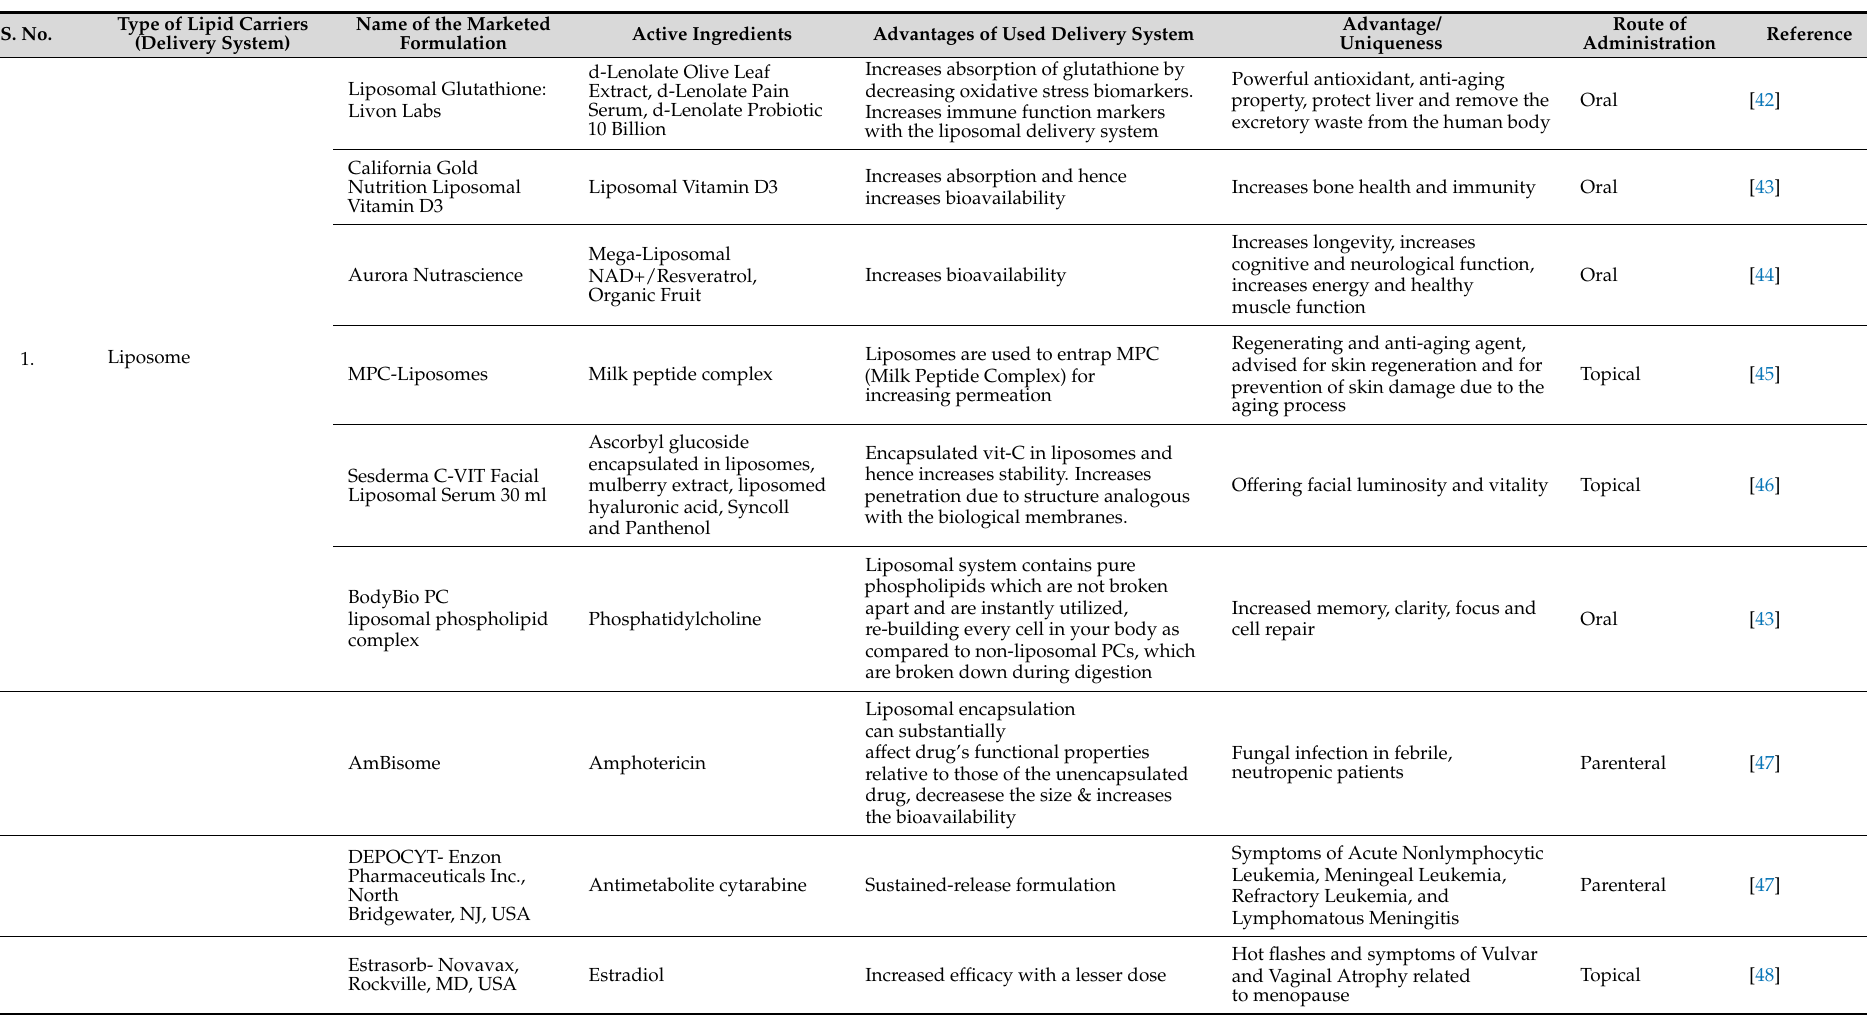
Table 1. Different marketed formulations incorporate lipid carriers for various